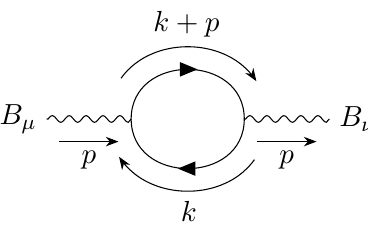
Figure 7. The diagram generating the B ∧ dB